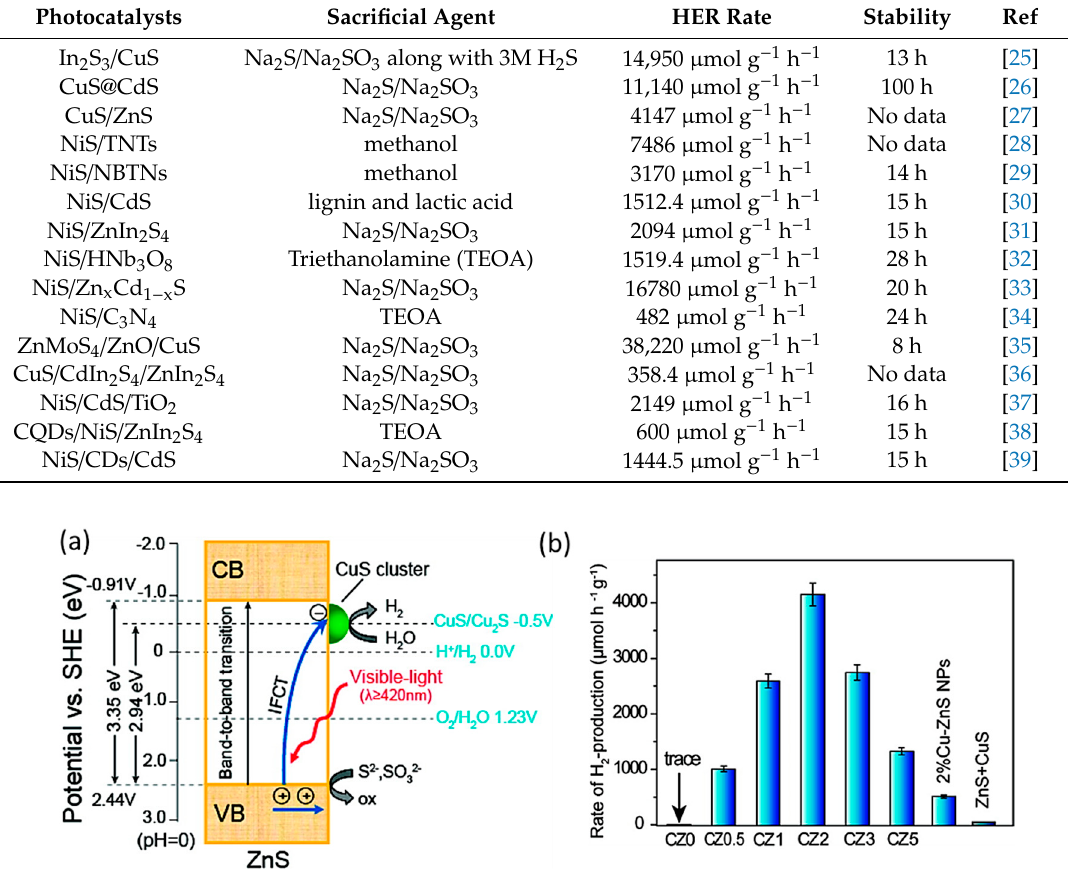
Figure 4. ( a ) Schematic illustration of interfacial charge transfer (IFCT) from the valence band of ZnS to the CuS clusters in CuS / ZnS system; ( b ) comparison of the H 2 -production activity of CuS / ZnS with di ff erent molar ratio and ZnS samples under visible light in a mixed solution with 0.35 M Na 2 S and 0.25 M Na 2 SO 3 as sacrificial agent. Adapted with permission from